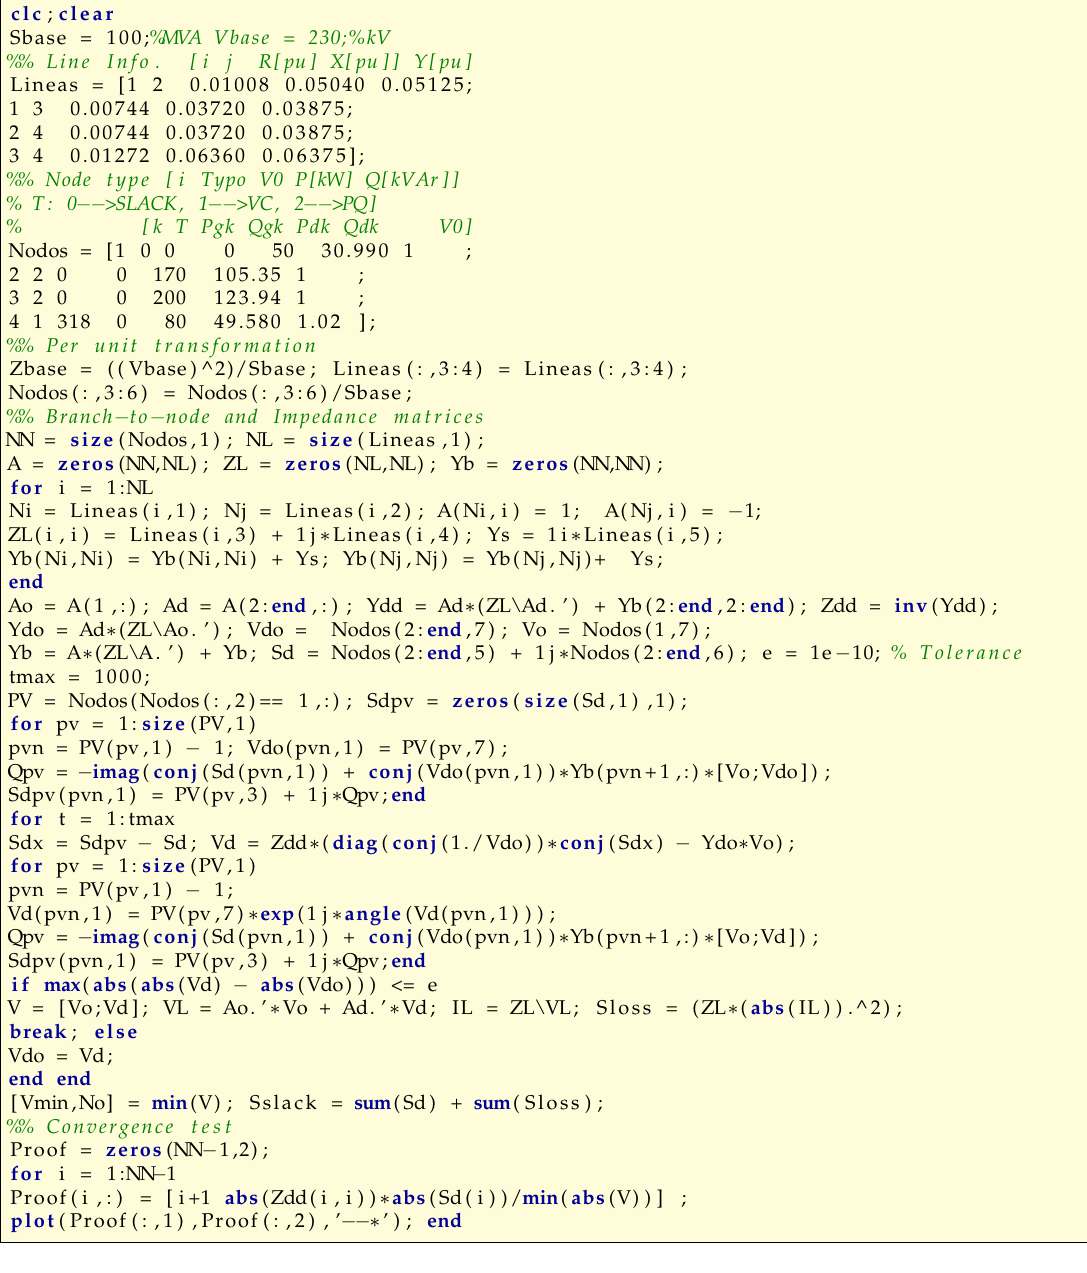
Figure A1. MATLAB implementation of the matricial iterative sweep power flow while considering VC